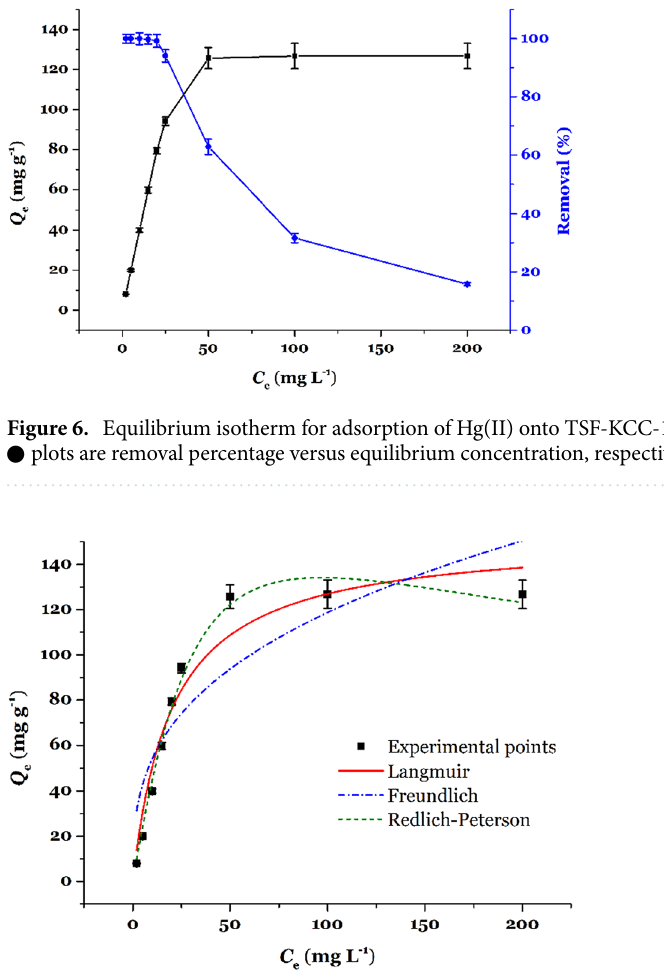
Figure 7. Equilibrium isotherm and non-linear fitting of isotherm models (Langmuir, Freundlich, and Redlich- Peterson).